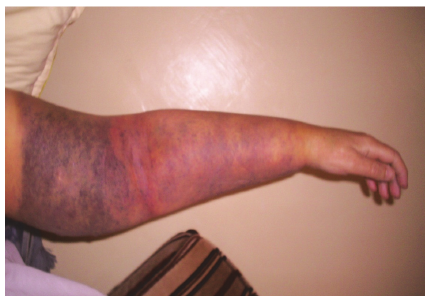
Figure 1: Left arm: mauve color with transitional tracer.